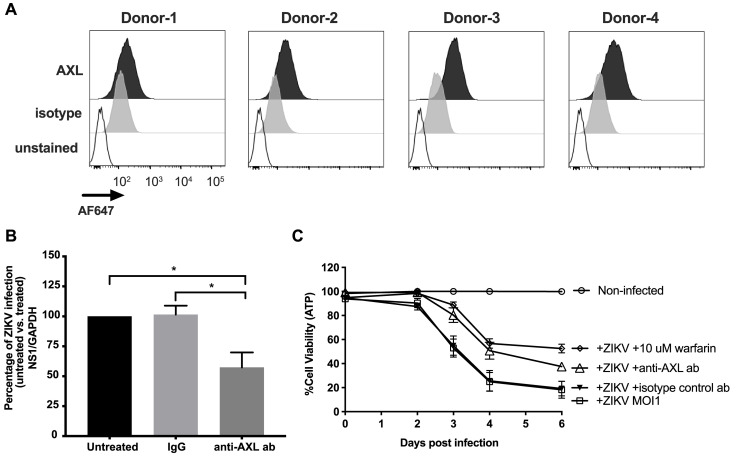
AXL antibody decreases ZIKV infection.(A) fcMSCs (donors 1–4) were stained with either isotype control or anti-AXL-APC antibodies as indicated on the panel and AXL expression was evaluated using flow cytometry. (B) fcMSCs were pre-treated with AXL blocking antibody or isotype control for 1 h and infected with MOI 1 of ZIKV for 6 h. Assessment of ZIKV replication in fcMSCs was performed by qRT-PCR quantification of NS1 mRNA levels 48 h post-infection. (C) fcMSCs were pre-treated with anti-AXL antibody (10 μg/mL), isotype control antibody, or warfarin and infected for 1 h prior to infection with 1 MOI ZIKV for 6 h, maintaining pre-treatment throughout duration, and cell viability was assessed at the indicated time points post-infection using the CellTiter-Glo Luminescent Cell Viability Assay.